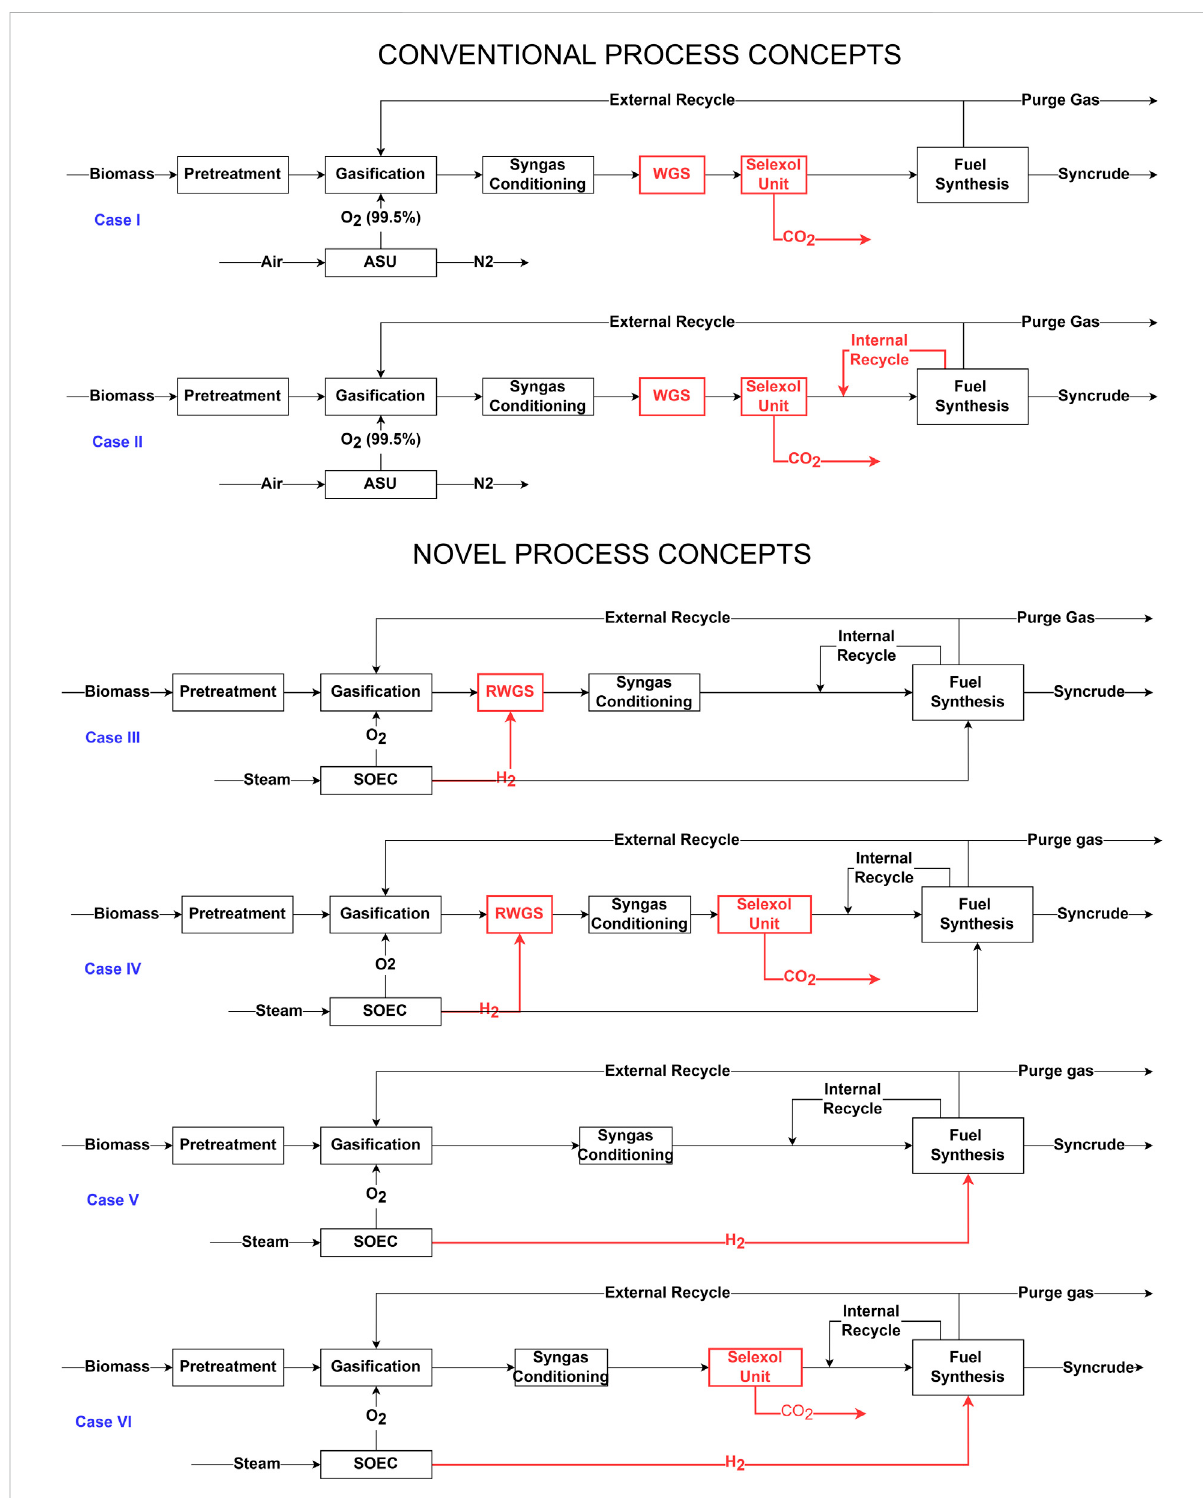
FIGURE 1 Simpli fi edblock diagram for different process concepts. Case I: Conventional BtL process with WGS and Selexol process and once-through FT synthesis.TheH 2 /COratioofthefeedinFTsynthesisis2.05.CaseII:CaseIwiththeintroductionofinternalrecyclinginFTsynthesis.TheH 2 /COratio of the feed in FT synthesis is optimized to 1.69. Case III: Integration of RWGS to the novel BtL process. Case IV: Case III with the removal of excess